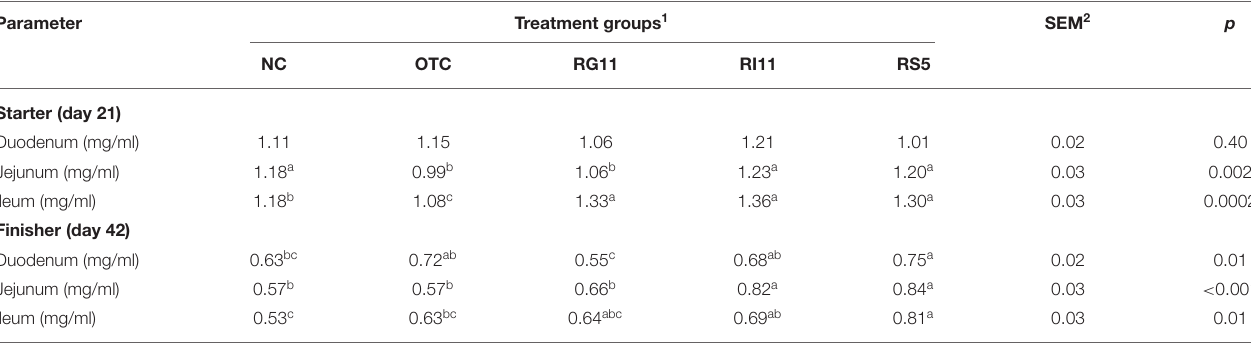
TABLE 11 | ITF activity of chickens when fed with different postbiotics. Parameter Treatment groups 1 SEM 2